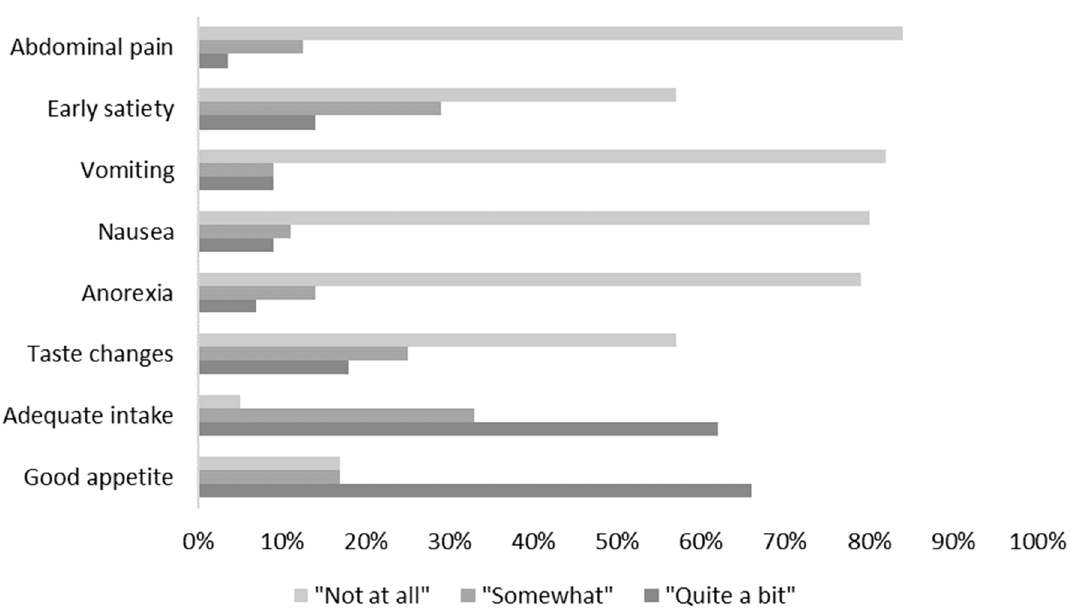
Figure 2. Percentage of patients experiencing food Figure 2 . Percentage of patients experiencing food symptoms.